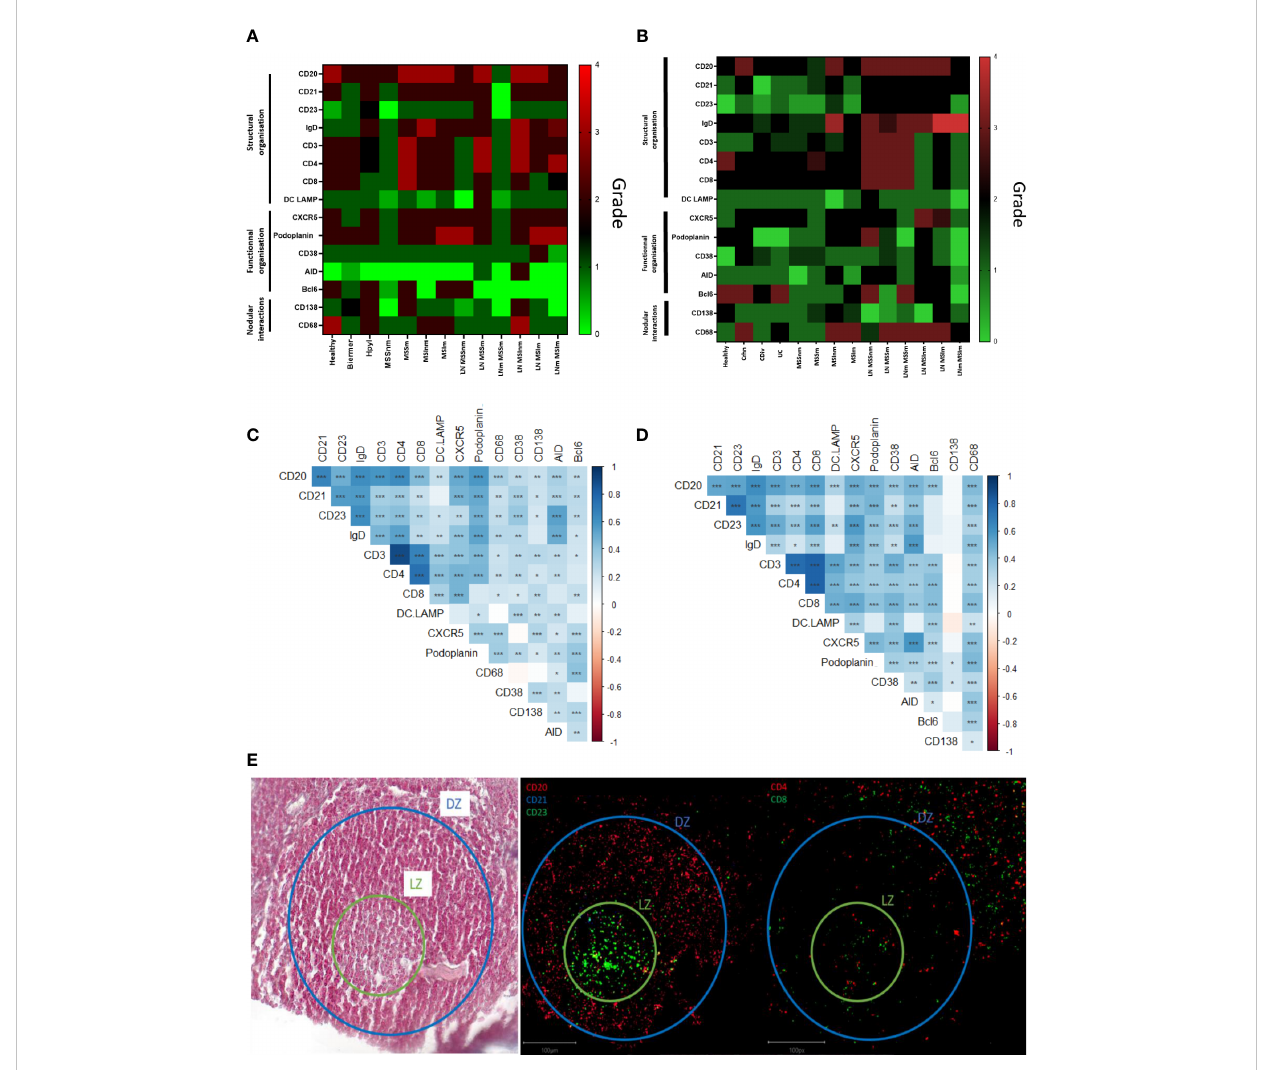
FIGURE 2 Semi-quantitative supervised analysis based on the scoring of 15 markers characterizing germinal centers and correlations between these markers in the TLS from gastric and colonic samples. (A) Heatmap representation of the average score observed for each marker for the different conditions observed in the stomach: 1) healthy, 2) in fl ammatory: Hpyl = patient with infection by Helicobacter pylori, Bierm = patient with Biermer ’ s disease, and 3) cancerous: patients with adenocarcinoma of MSI- or MSS- status, with a non-metastatic (-nm) or metastatic stage (-m). (B) Heatmap representation of the average score observed for each marker for the different conditions observed in the colon: 1) healthy, 2) in fl ammatory: Crhn = patient with Crohn ’ s disease, UC = patient with ulcerative colitis, and Cdiv = patient with chronic diverticulitis, and 3) cancerous: patients with adenocarcinoma of MSI- or MSS- status, with a non-metastatic (-nm) or metastatic stage (-m). The follicles from LN without nodal metastasis (LN) and with nodal metastasis (LNm) are also included in the analysis revealing a more mature structural organization in LN than in TLS. (C) Heatmap representation of the correlation between the markers in gastric TLS. (D) Heatmap representation of the correlation between the markers in colonic TLS. Correlated and uncorrelated markers are shown in dark blue to red respectively. Closer are the markers on the fi gure, higher are their correlation. Signi fi cative p-values are represented with stars: * = p<0.05, ** = p<0.01, *** = p< 0.001. (E) IMC images of the light (LZ) and dark zone (DZ) in a GC of a TLS from a Crohn ’ s disease sample with the corresponding HE image on the